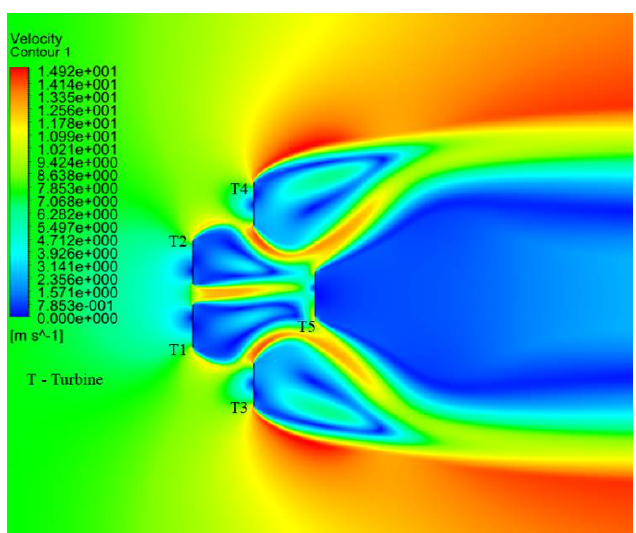
Figure 10. Velocity contours for the pentagon platform.